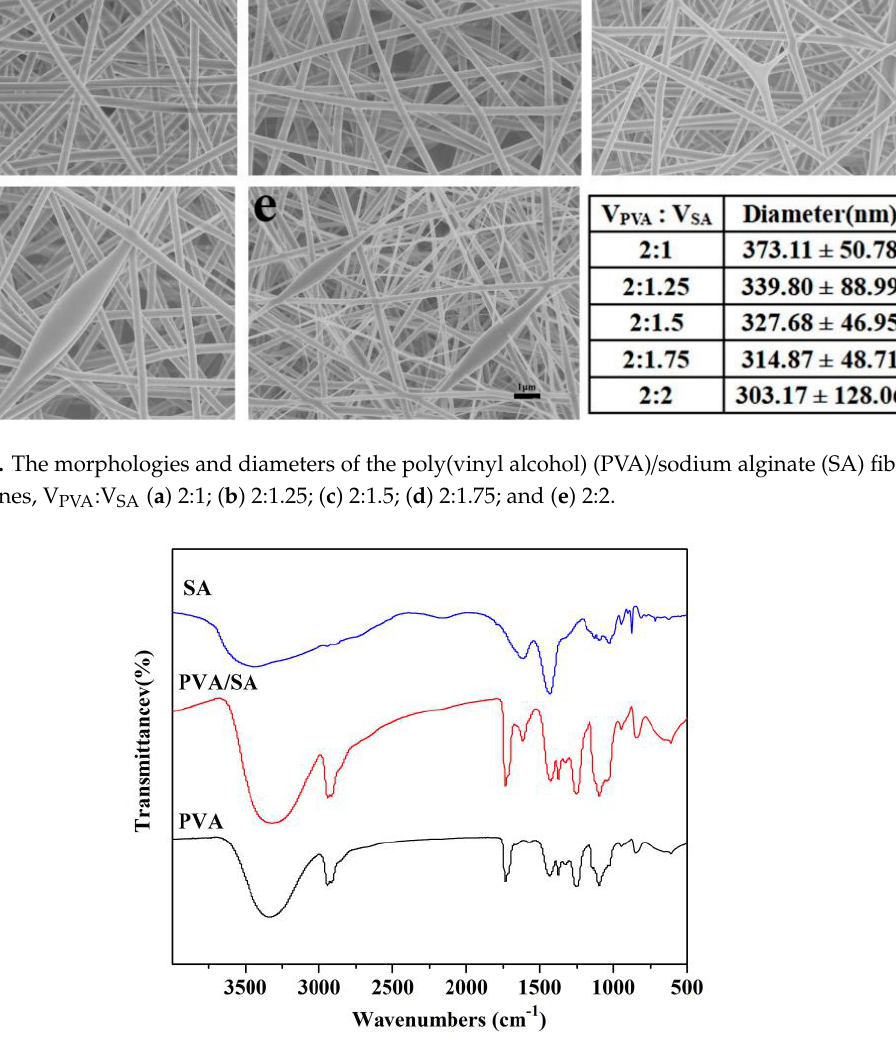
Figure 4. The contact angles of the PLA/PVA/SA composite fiber membrane, ( a ) the top layer of the PVA/SA fiber membrane, and ( b ) the bottom layer of the PLA fiber membrane.